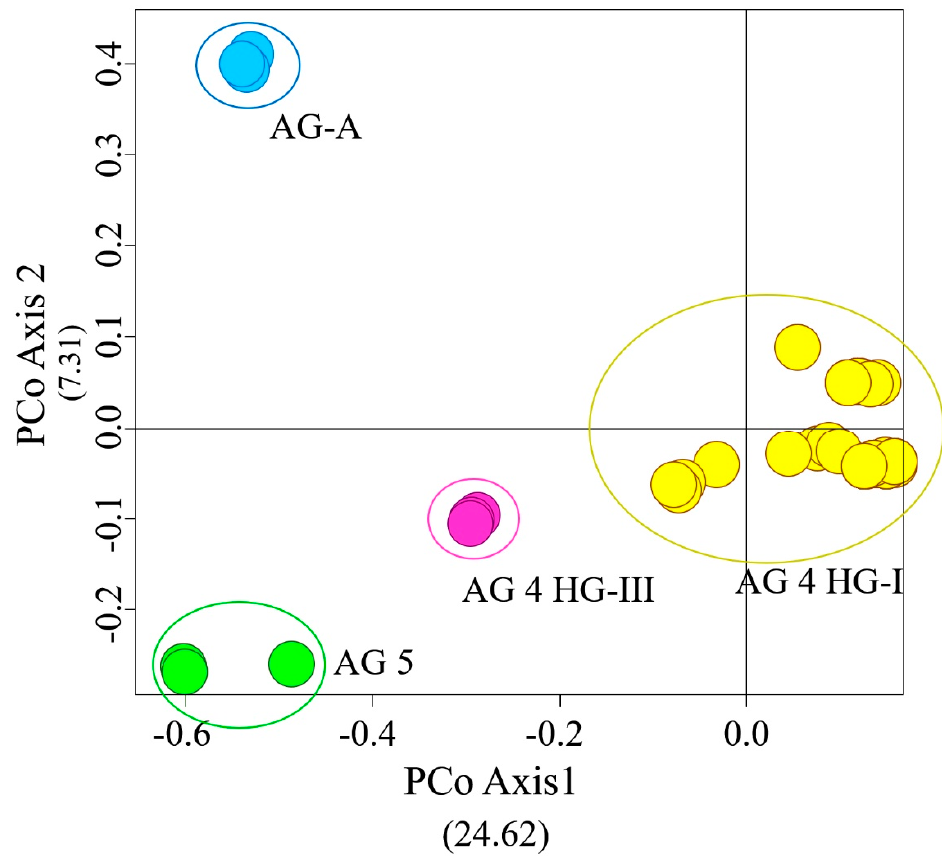
Figure 4. Association matrix for anastomosis groups, based on principal coordinate analyses.